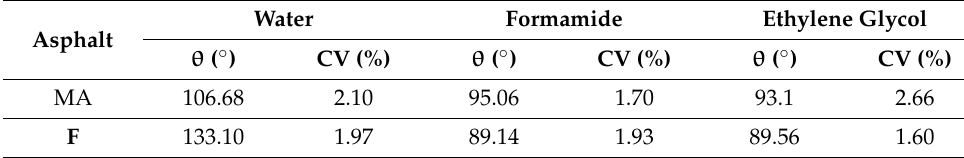
Table 4. Contact angles ( θ ) and coefficient of variance (CV%) of MA and PPWA with three probe liquids.